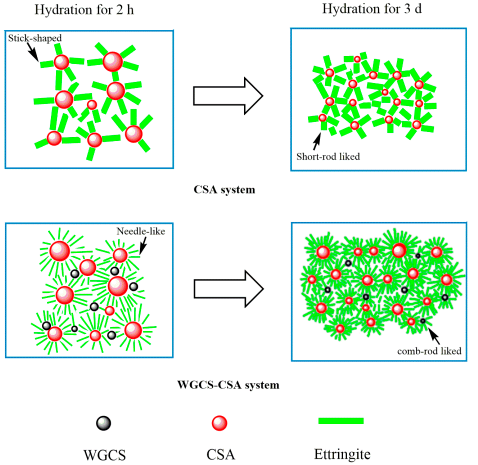
Figure 9. The mechanism of hydration in CSA and WGCS–CSA system.